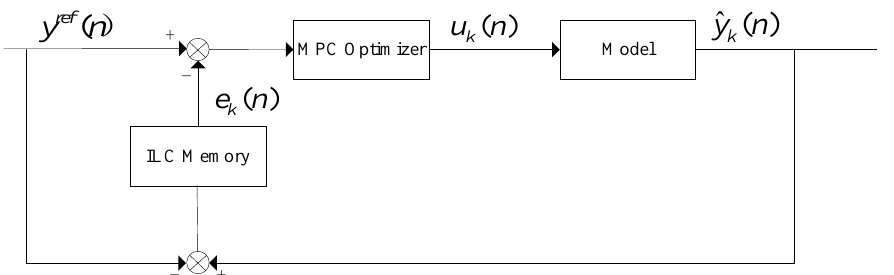
Figure 5. Iterative learning model prediction